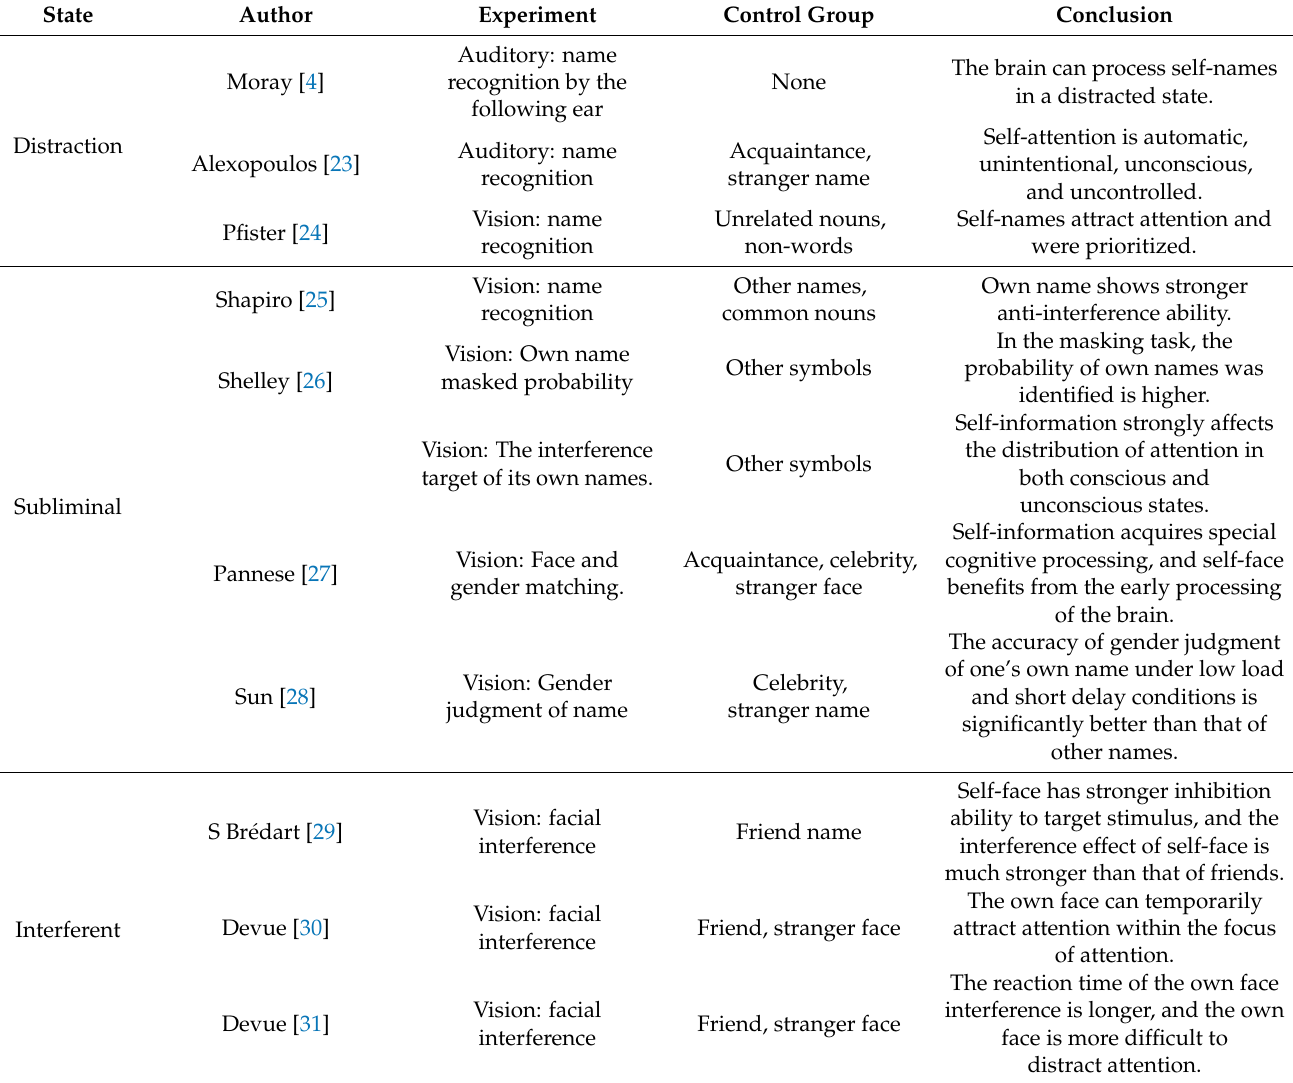
Table 2. The sensitivity of